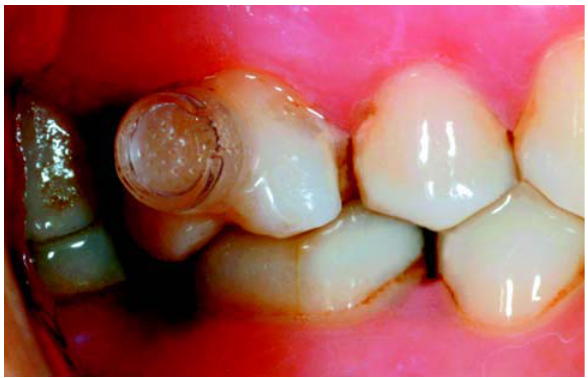
FIGURE 5- Latest glass device and bracket attached to upper first permanent molar